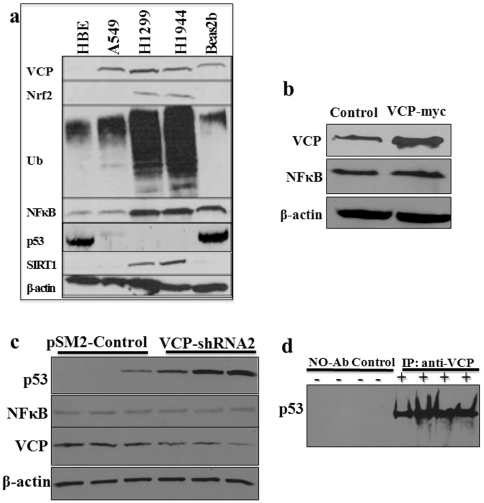
VCP regulates protein levels of p53, NFκB and other cancer-related proteins.(a) We observed the accumulation of ubiquitinated proteins, induction of VCP, Nrf2, SIRT1 (Sirtuin 1, stress regulator), and NFκB, and suppression of p53 in NSCLC cell lines (H1299 and H1944) as compared to control (Beas2b and HBE) cells indicating towards proteostasis-imbalance. β-actin antibody was used as an equal-loading control. NFκB, p53, Nrf2 and SIRT1 are known to be involved in tumor metastasis, proliferation, apoptosis and inflammatory-oxidative stress responses. (b) VCP overexpression (VCP-myc) in H1299 cells shows an increase in NFκB protein levels. (c) H1944 cells transfected with VCP shRNA (lane 4–6) show a significant increase in p53 protein levels and decrease in NFκB, as compared to pSM2 control (lanes 1–3). VCP immunoblot verifies VCP inhibition while β-actin shows equal loading. (d) Co-immunoprecipitation (IP) of p53 with VCP antibody verifies the novel protein-protein interaction. IP lacking anti-VCP antibody was used as a negative control. Regulation of oncogene and tumor suppressor by VCP provides a potential mechanism for its critical role in tumor progression and metastasis.